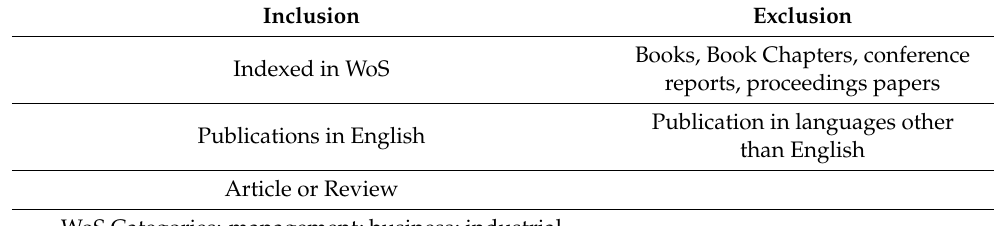
Table 1. Inclusion and exclusion criteria (Source: Own elaboration).